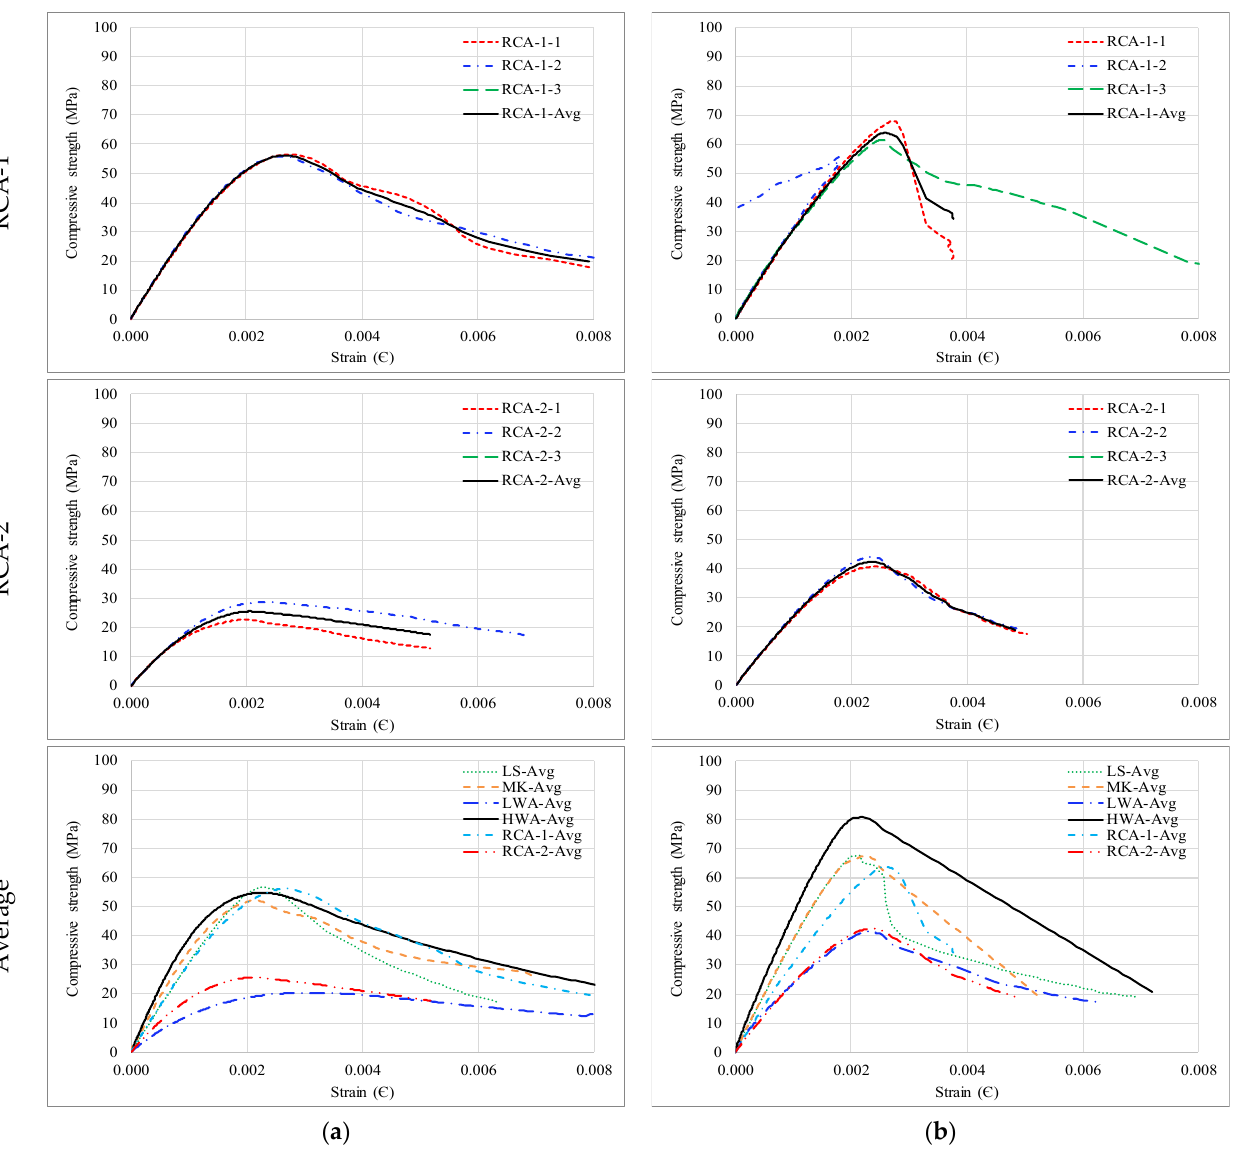
Figure 6. Stress–strain variation for: ( a ) Mix 1; and ( b ) Mix